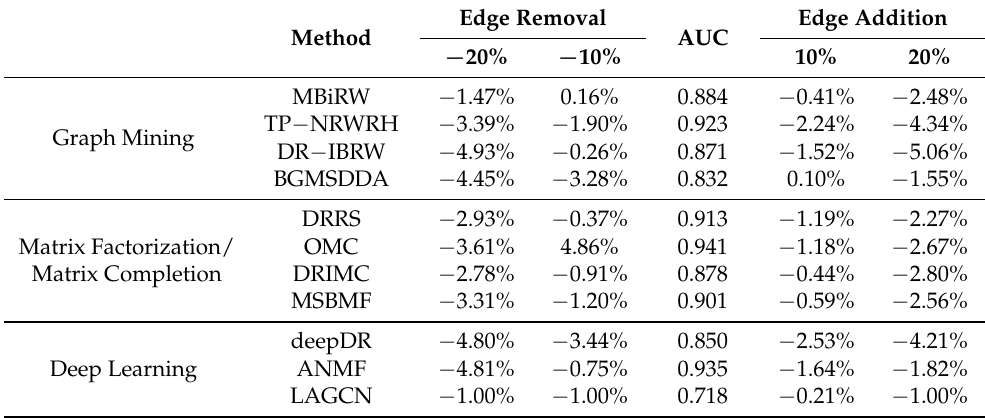
Table 5. AUC of drug–disease association prediction results using a gold standard dataset, and the increasing or decreasing rates of the AUC by removing and adding 10% and 20% of drug–disease associations,